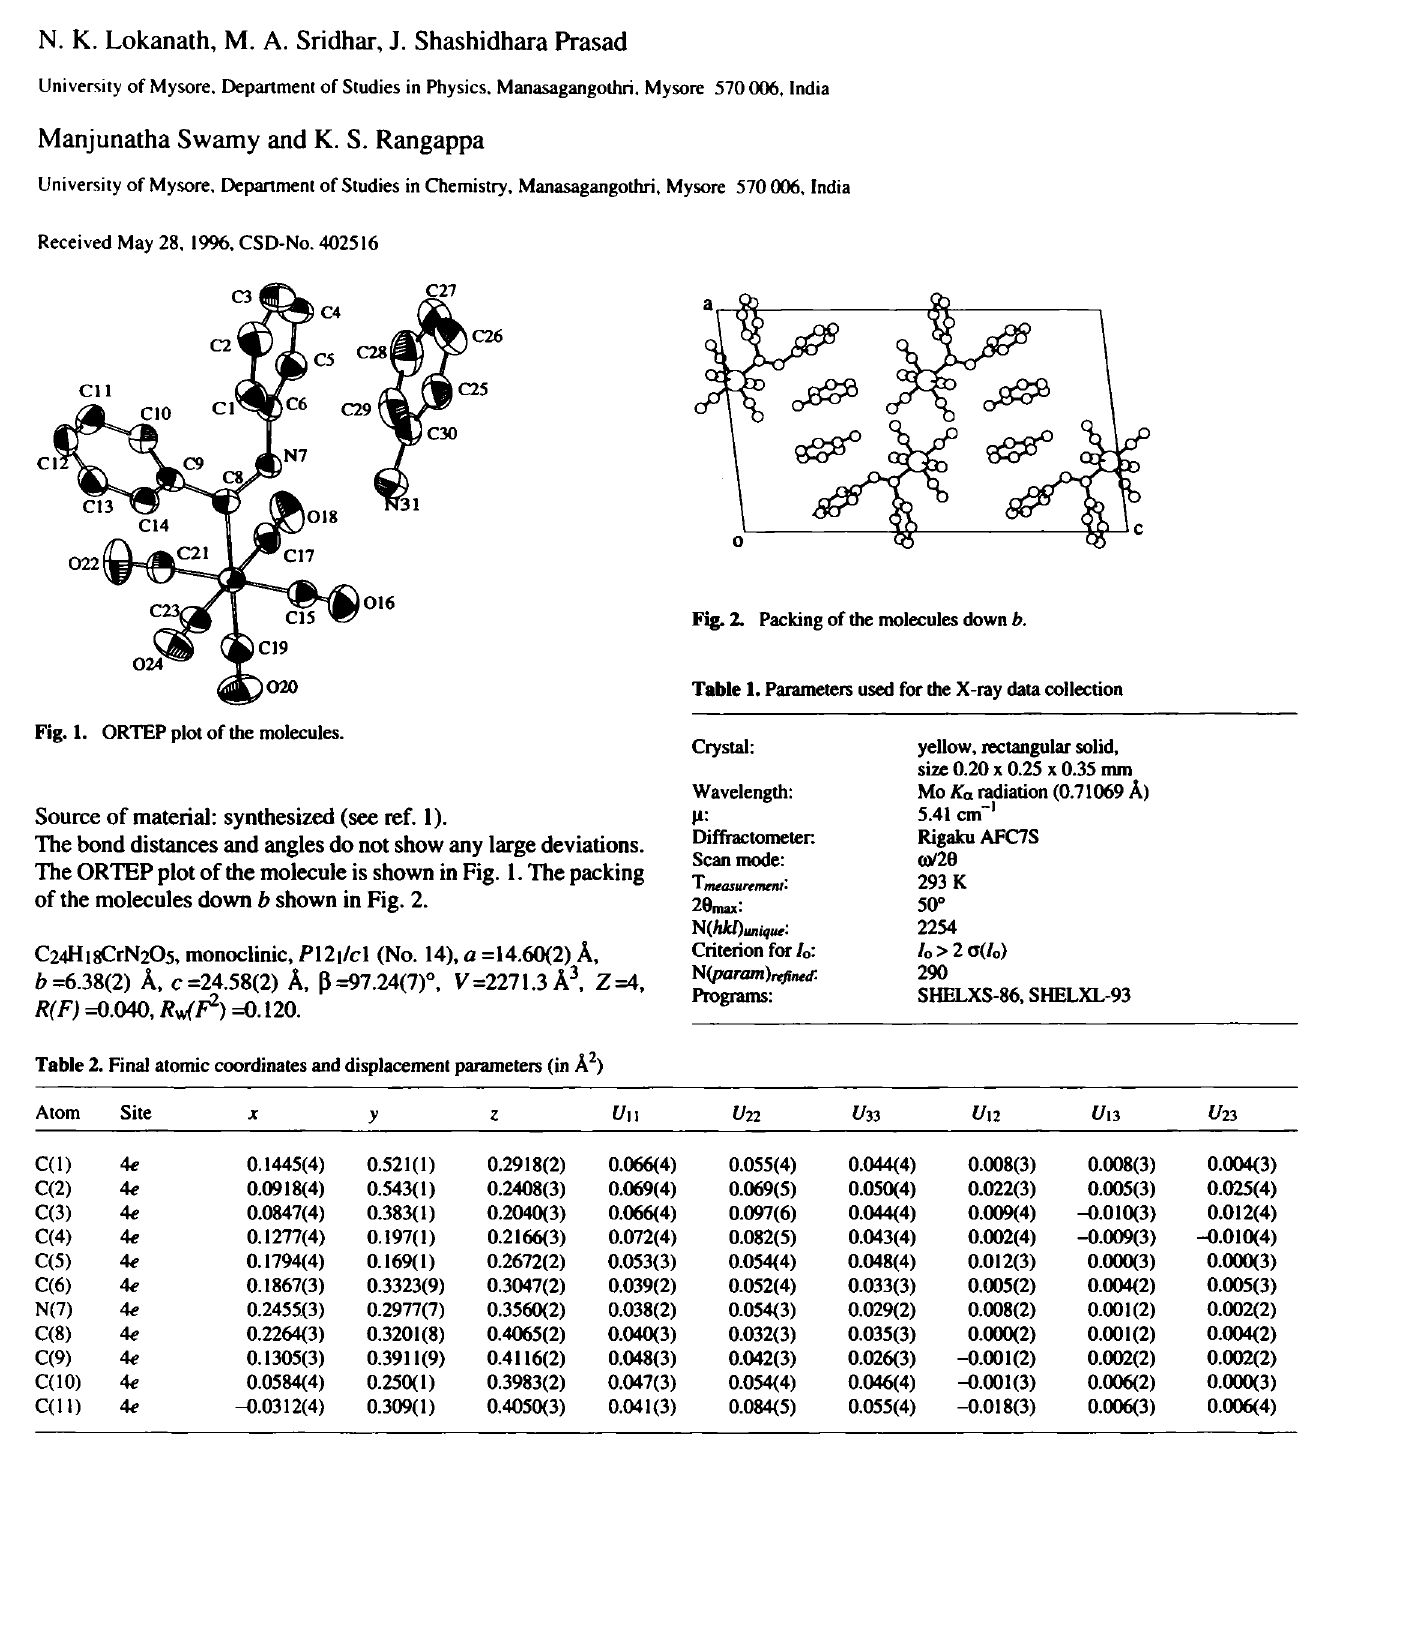
Fig. 2. Packing of the molecules down b. Table 1. Parameters used for the X-ray data collection